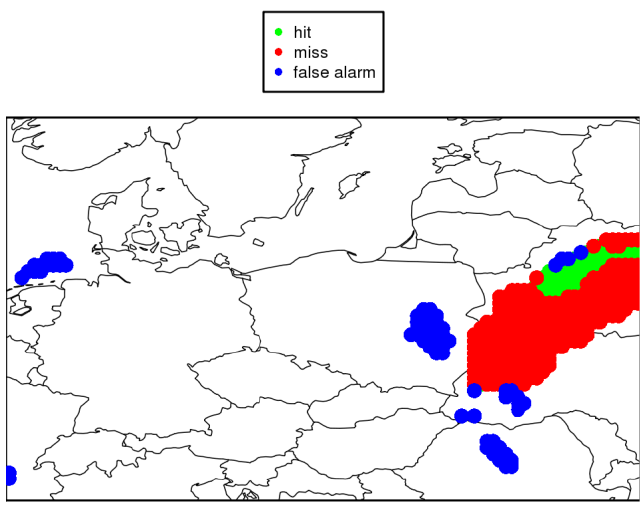
Figure 6. Resultsof the trainedsystemwith respectto removing thesurfacefields fromthe trainingdatabase.